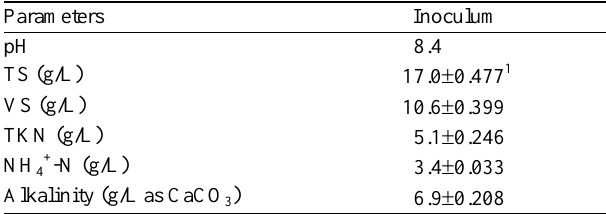
Table 1. Anaerobic inoculum characteristics